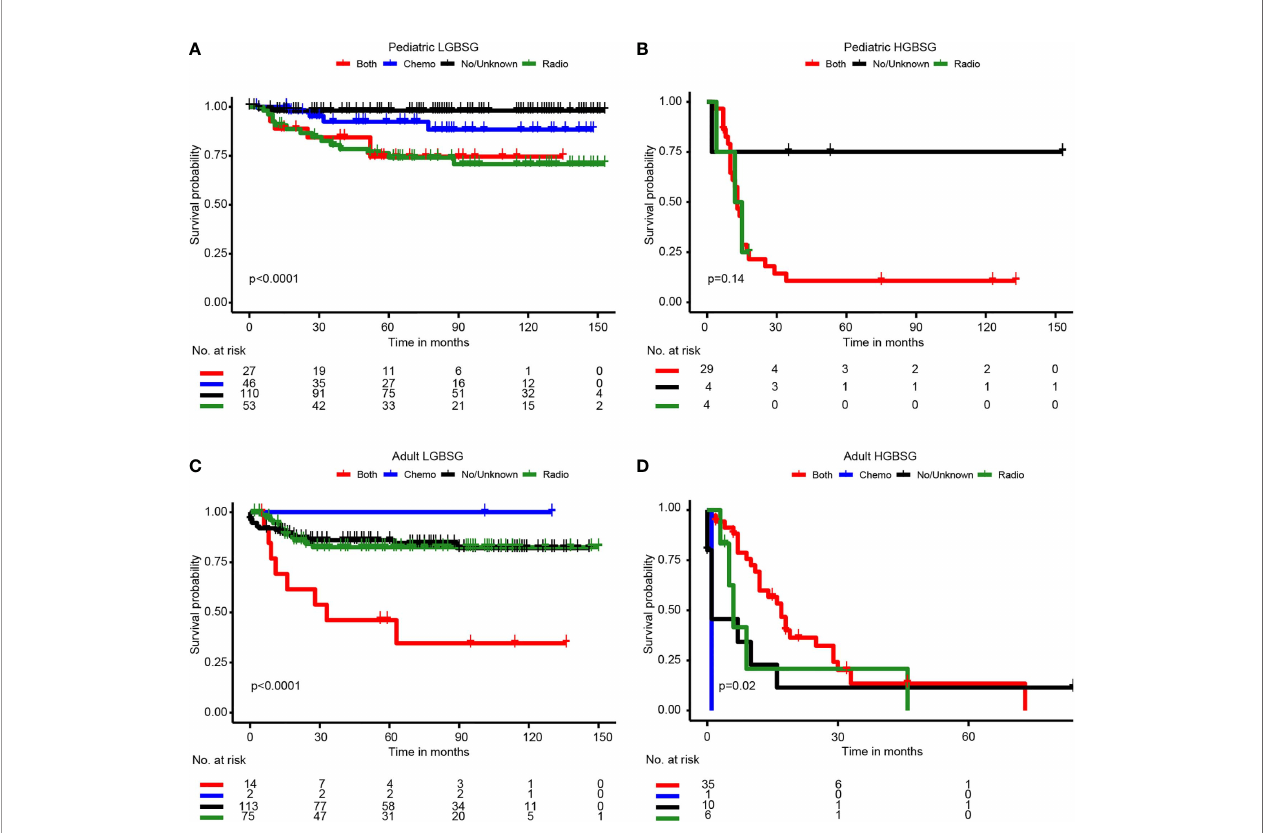
FIGURE 3 | Kaplan-Meier curves by adjuvant therapy in different patient groups. (A) pediatric LGBGG; (B) pediatric HGBSG; (C) adult LGBSG; (D) adult HGBSG